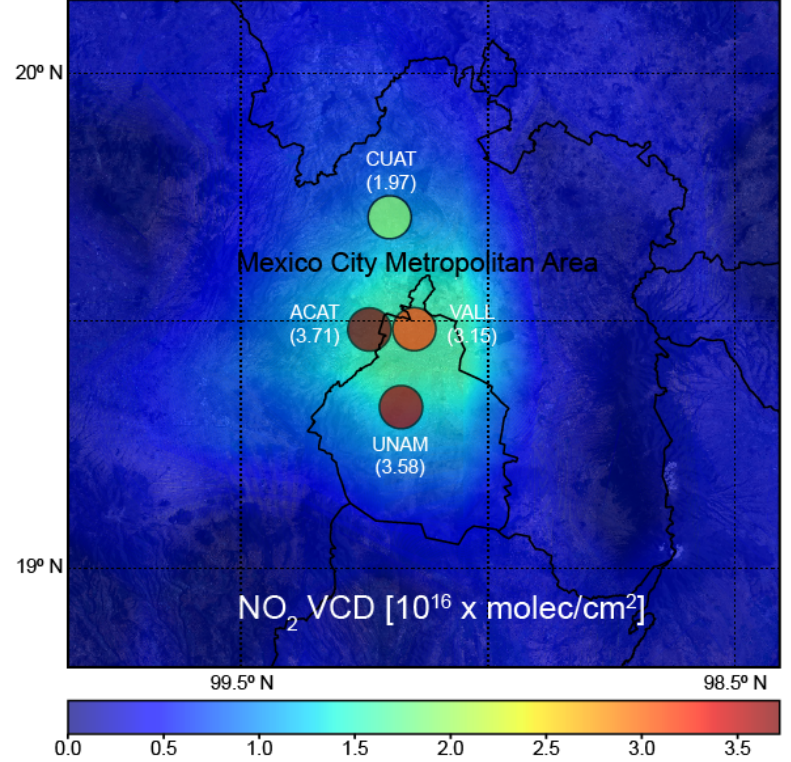
Figure 2. Spatial distribution of the NO 2 VCD monthly averages from the OMI-DOMINO product during the 2013 to 2018 period, together with the overall overpass-time averages from the MAX- DOAS instruments (colored circles) over the MCMA (UNAM: 2013–2018, ACAT: 2015–2017, VALL: 2015–2018, CUAT: